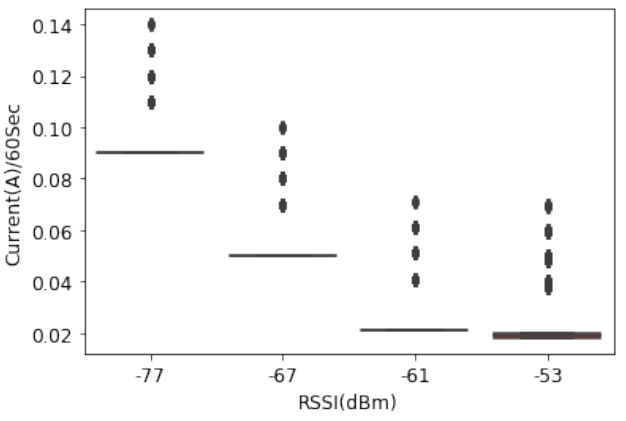
Figure 14. Current consumption vs. RSSI in 60-second time stamps.